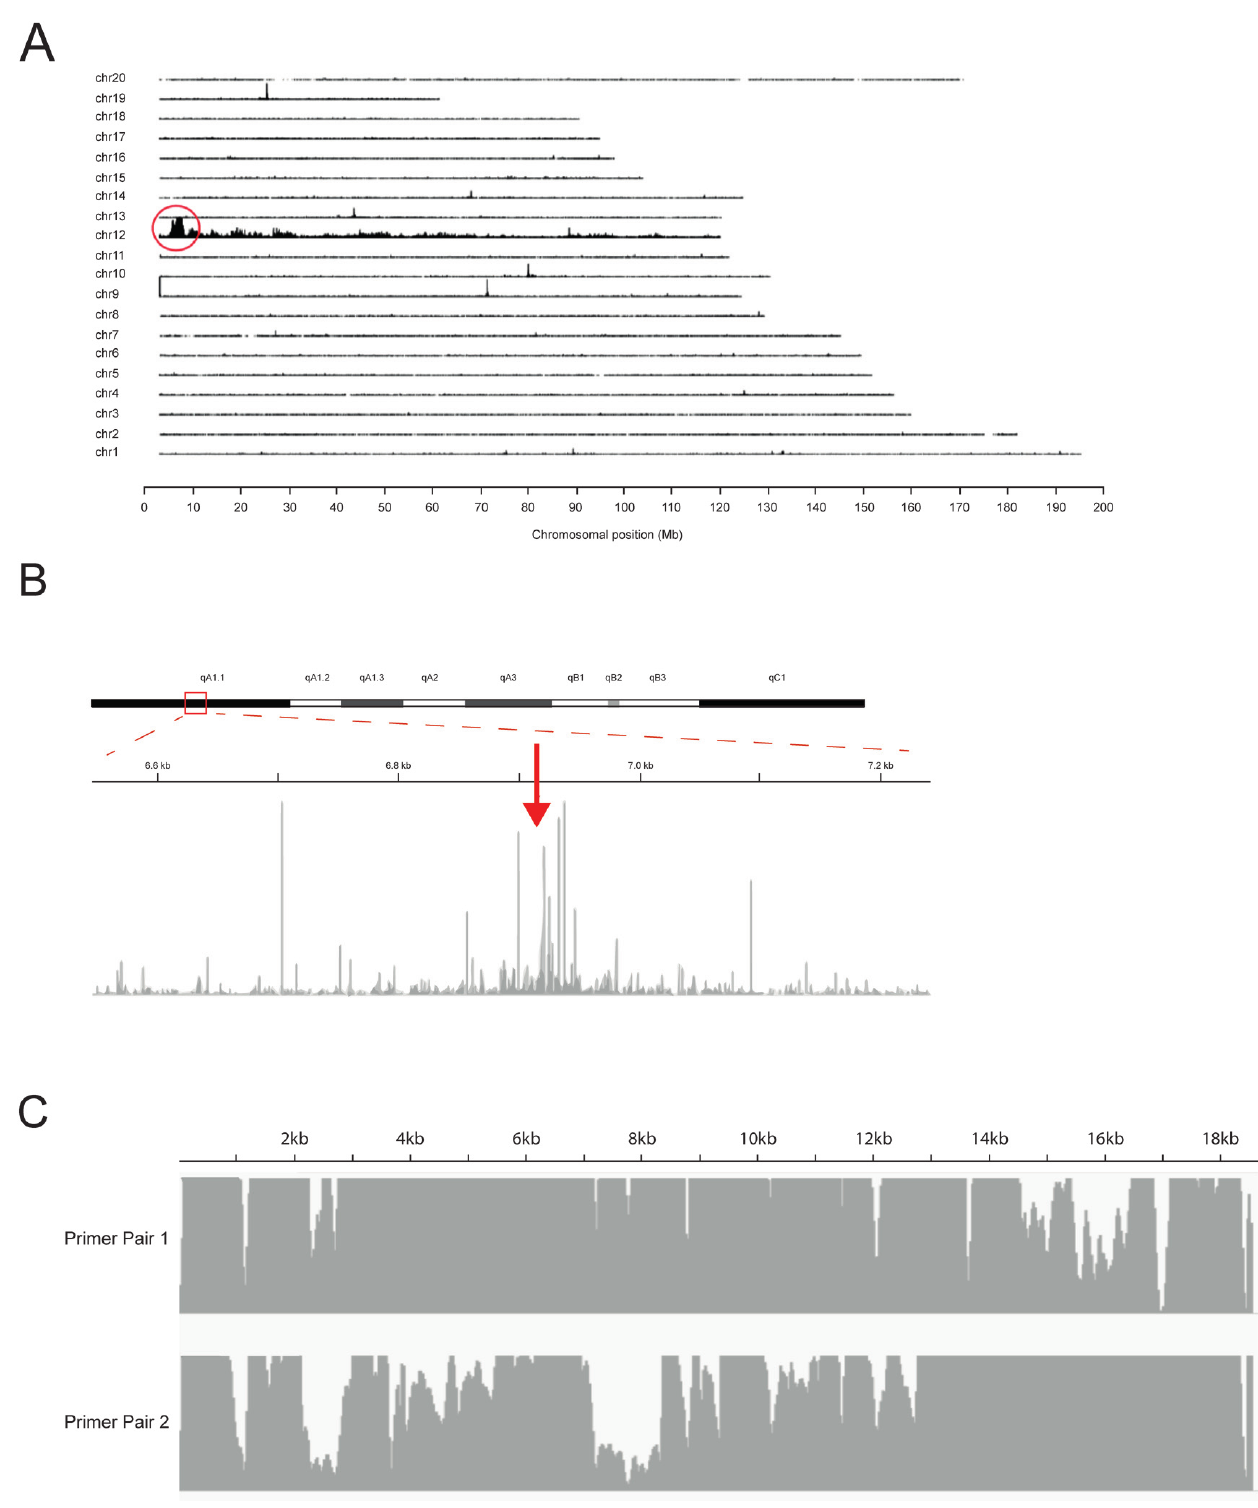
Figure 1. ( A ) Targeted locus amplification (TLA) sequence coverage across the mouse genome using primer set 1. The chromosomes are indicated on the y-axis, the chromosomal position on the x-axis. Similar results were obtained with primer set 2 (see Underlying data 4 ). ( B ) TLA sequence coverage across mouse chromosome 12 with primer pair 1. The arrow points towards the integration site. ( C ) TLA sequence coverage across the TG with primer pair 1 (top) and 2 (bottom).